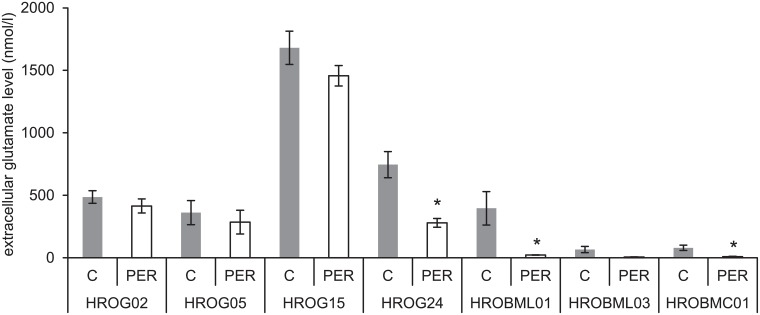
Glutamate release of glioblastoma and brain metastasis cells.In subconfluent cell cultures, supernatants (w/o FCS) were collected for a total of 24 hours (± PER) and glutamate levels were determined. Extracellular glutamate levels were normalized to total protein levels of the cells. Data are presented as mean ± SEM (n≥14), *p<0.05 vs. solvent control (Mann-Whitney U test). Multiple comparisons versus control groups (two-way ANOVA with Bonferroni t-test) demonstrated an overall higher glutamate level in the supernatant of glioblastoma cells than in the supernatant of metastasis cells (p<0.001). Additionally, the two-way ANOVA also revealed a significant treatment effect, i.e. PER attenuated extracellular glutamate levels across all cell cohorts (p = 0.046).